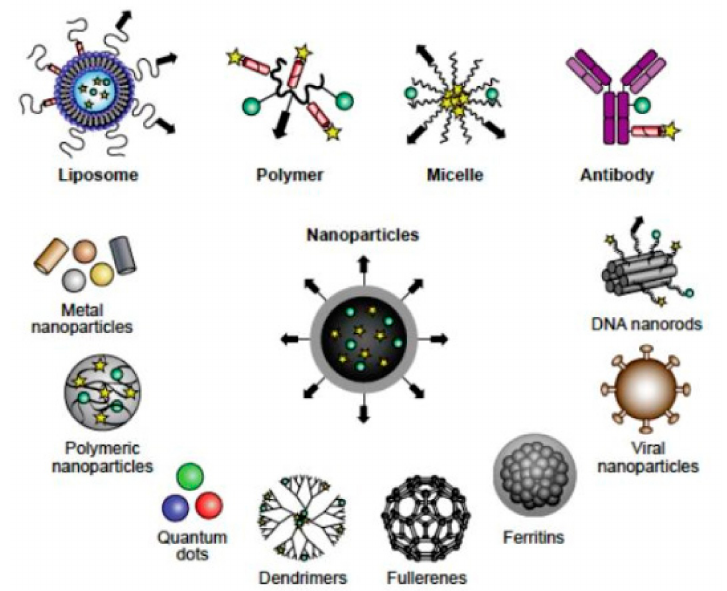
Figure 7. Biocompatible nanocarriers include those composed of liposomes, polymers, micelles, antibodies, nanoparticles composed of metals, and other biological molecules or combinations